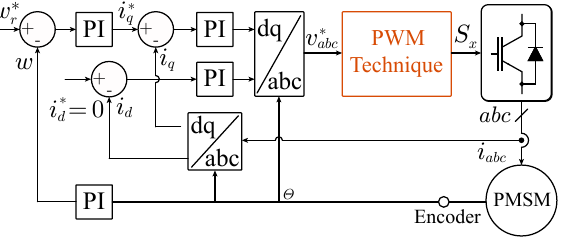
Figure 11. Controller scheme implemented in the experimental